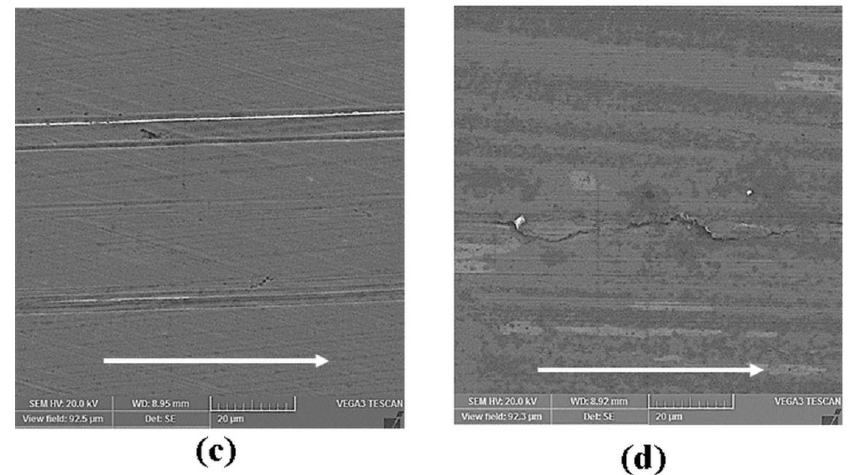
Figure 8. Scanning electron micrographs after tribological testing of: ( a ) SF; ( b ) SF + 0.01 wt. % HNTs; ( c ) SF + 0.05 wt. % HNTs; ( d ) SF + 0.10 wt. % HNTs. Arrows indicate the direction of sliding.